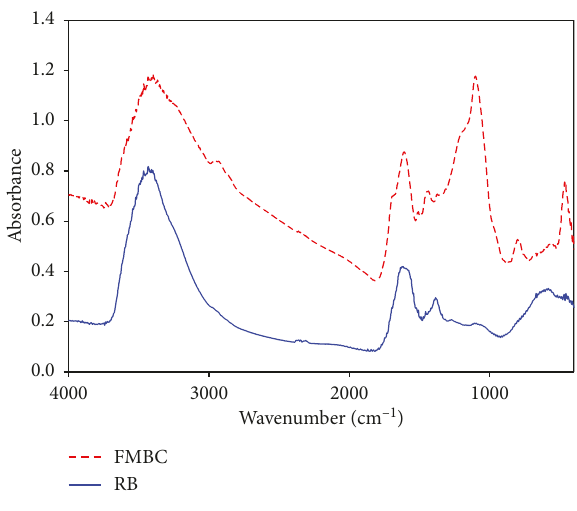
Figure 2: FTIR spectra of RB and